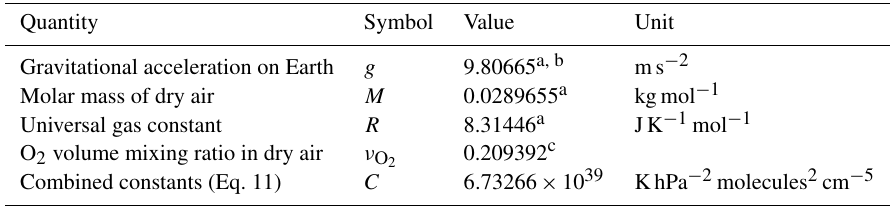
Table 2. Constants used in this study. Numbers are listed with six